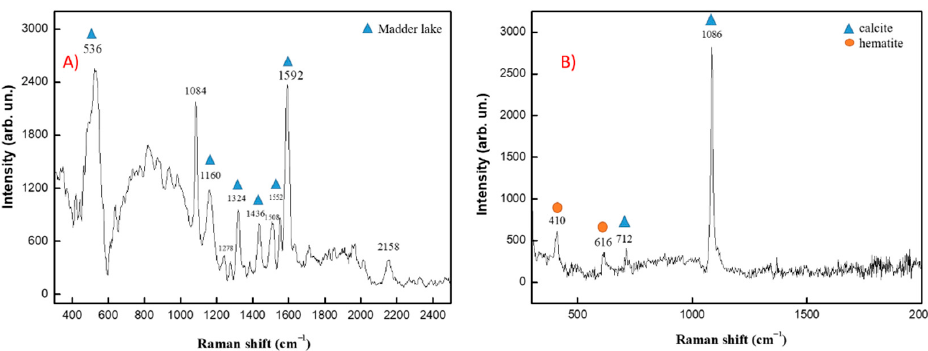
Figure 22. Raman spectra of red pigment; ( A ) in situ, point 1; ( B ) sample.